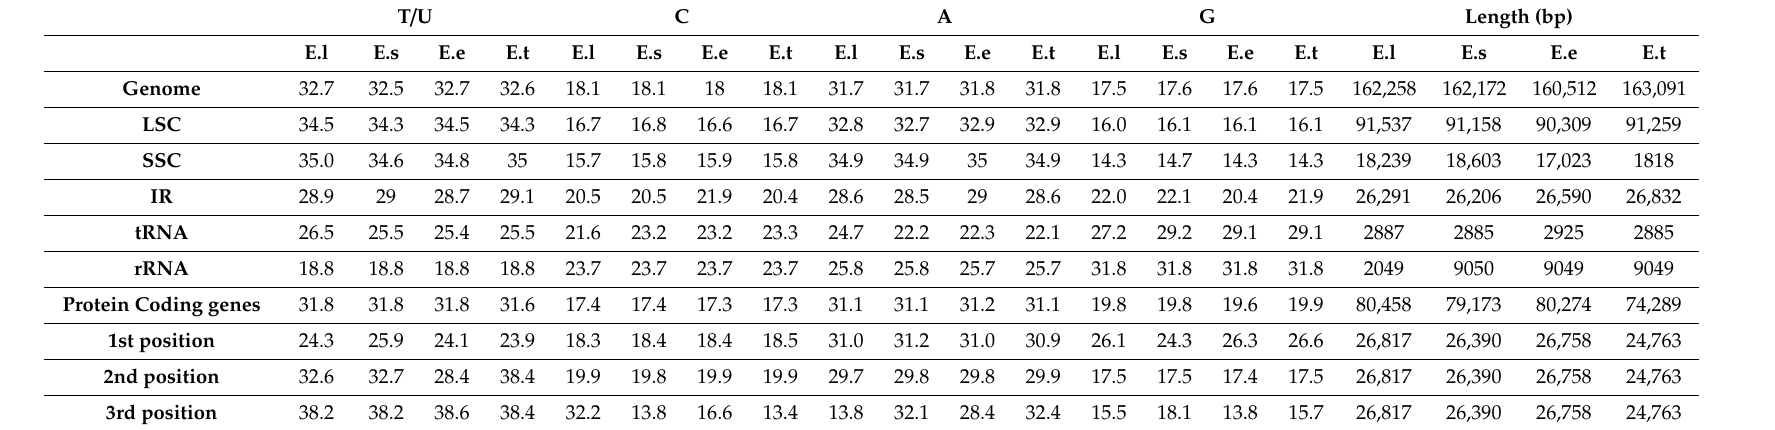
Table 3. Base composition of the Euphorbia species in the chloroplast